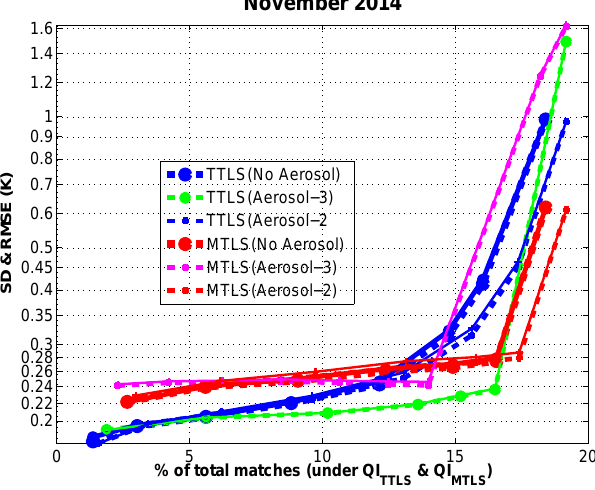
Figure 2. Plots of MTLS and TTLS retrievals under both MTLS and TTLS QI for three scenarios: No aerosol with two retrieved parameters, aerosol with two retrieved parameters, and aerosol with three retrieved